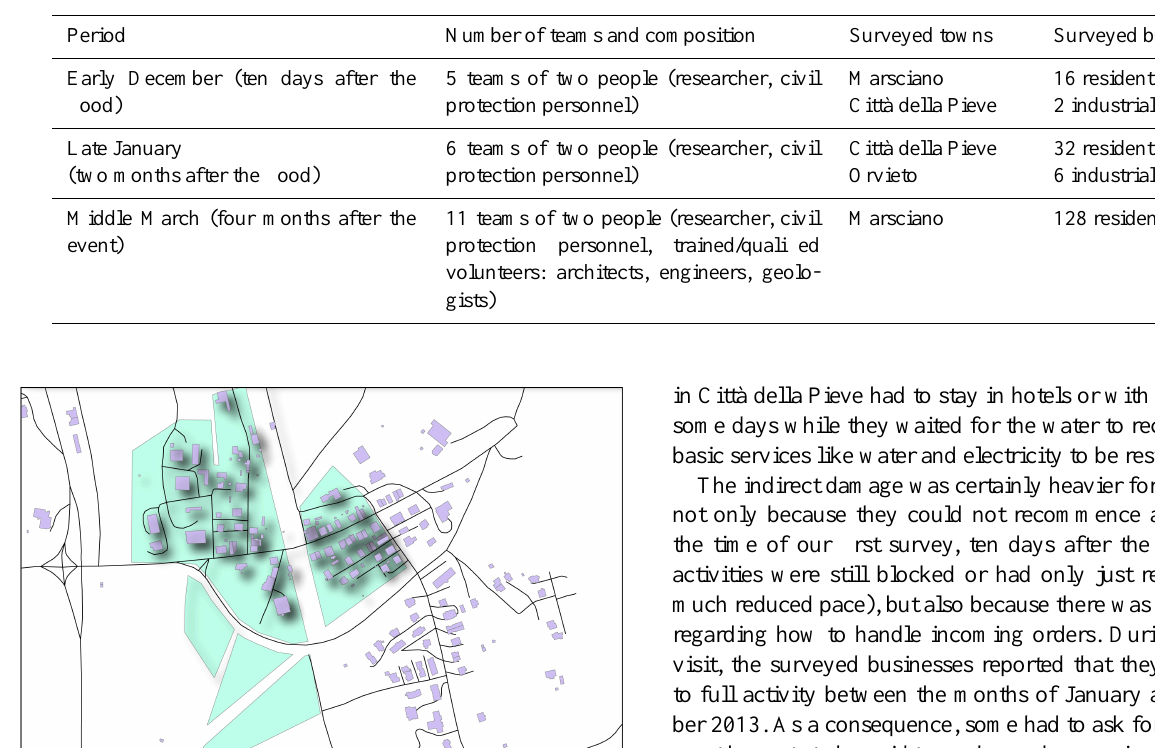
Table 6. History of field surveys.